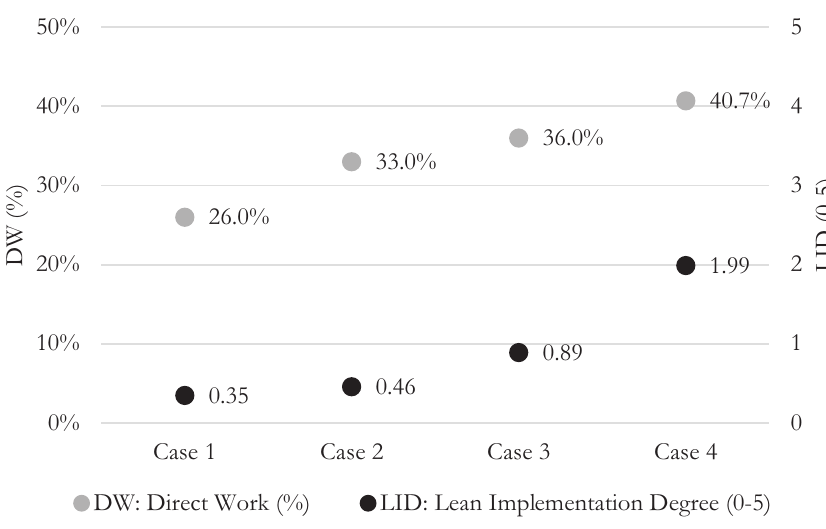
Figure 2. Connected DW and LID values for the four cases.